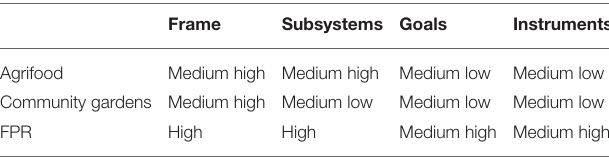
TABLE 7 | Degree of policy integration divided into four dimensions according to Candel and Biesbroek (2016) framework (source: authors).